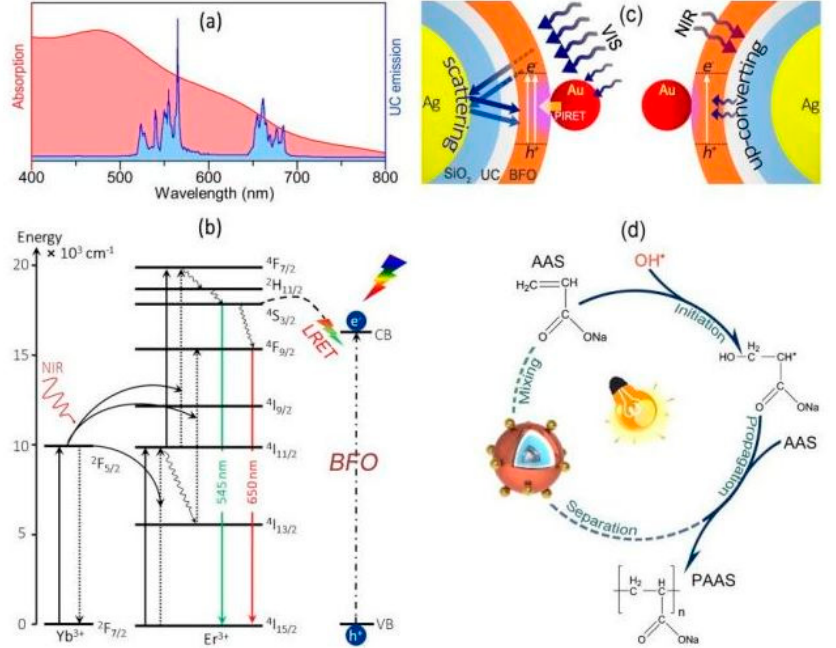
Figure 6. ( a ) Schematic illustration of spectral overlap of the absorption (red) of the BFO shell and emission (blue) of the upconverting core. ( b ) Energy level diagrams of Yb 3+ and Er 3+ ions, as well as the upconverting luminescence process upon NIR excitation; the energy transfer from upconverting core to BFO shell. ( c ) SPR enhanced the photoactivity of Ag@SiO 2 @UC@BFO-Au under VIS and NIR excitation. ( d ) Schematic process of the AAS photo-polymerization using Ag@SiO 2 @UC@BFO-Au as a photoinitiator [31].